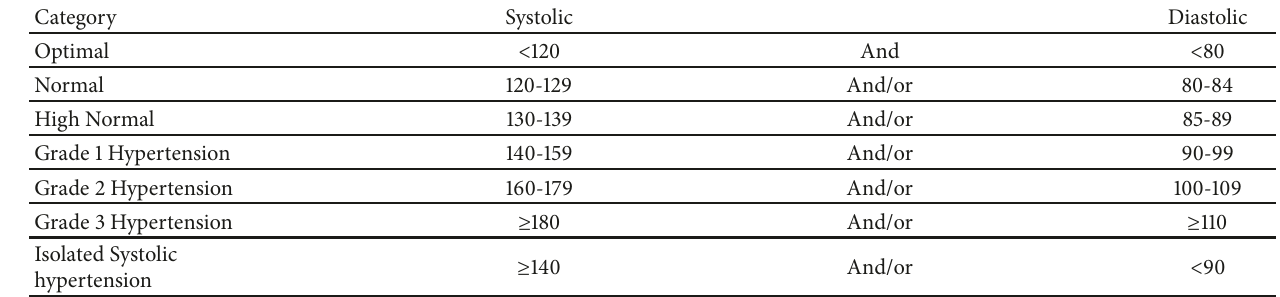
Table 2: Blood pressure levels (mmHg).